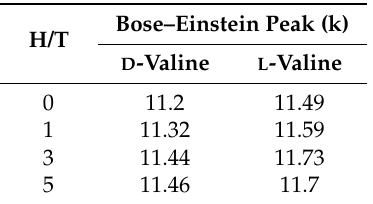
Table 5. Temperatures of Bose–Einstein peak of D - and L -valine. Bose–Einstein Peak H/T